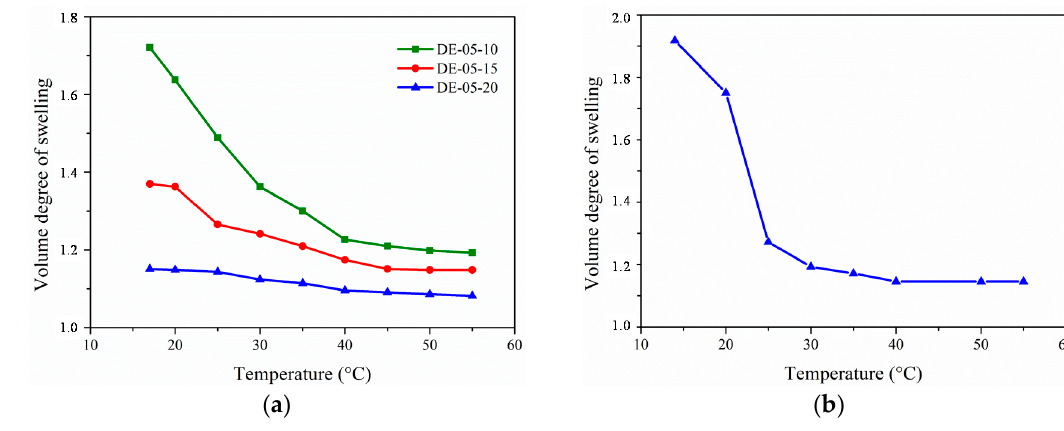
Figure 4. Volume degree of swelling vs. temperature of photo cross-linked hydrogels in water; (a ) DE-05-10, DE-05-15 and DE-05-20; ( b ) DM-05-20.